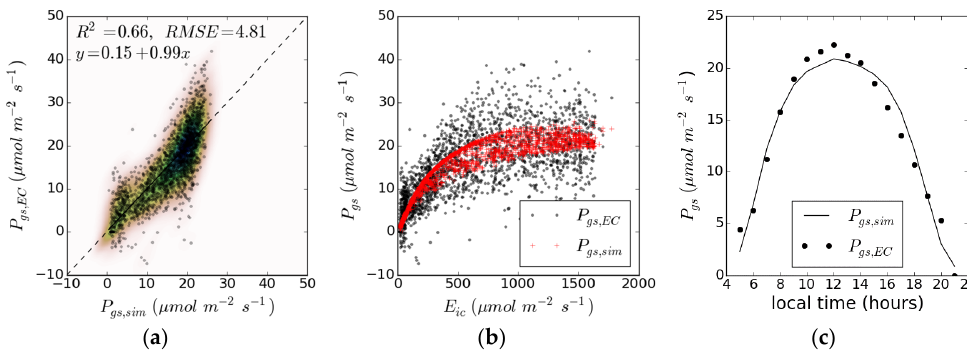
Figure 5. Model inversion for case 1 (2094 observations, no cross validation): absence of down-regulation functions. Shown is ( a ) the correlation with eddy-covariance derived gross primary productivity estimates; ( b ) the distribution of measured and simulated estimates of gross primary productivity against incident photosynthetically active radiation; ( c ) average diurnal responses. See Table 1 and text for an overview of parameters used for the different cases and Table 2 for an overview of parameter estimates obtained through model inversion.